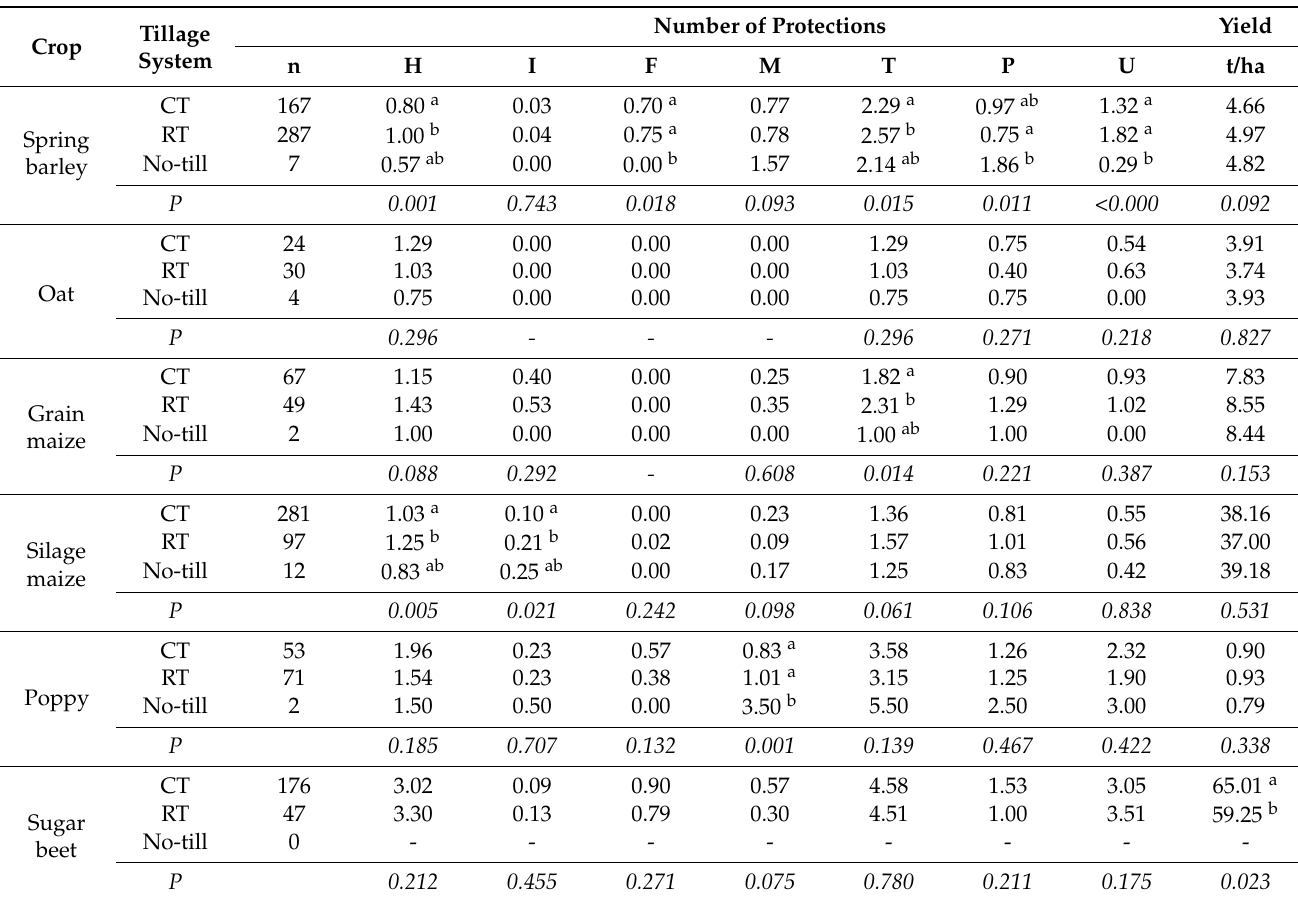
Table A12. Number of chemical protections of evaluated spring crops cultivated at different tillage systems; average of years 2002–2010.